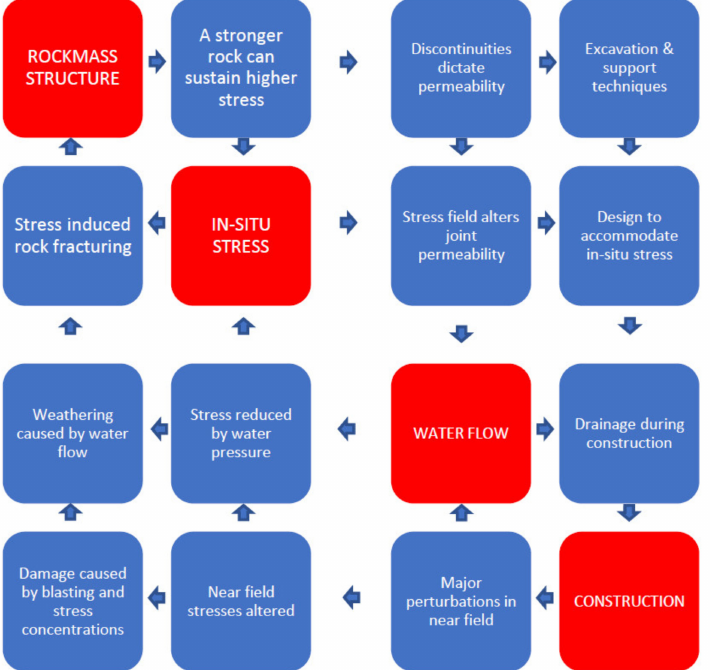
Figure 2. An example of a simple, four-variable, binary interaction matrix (BIM), modified from [10,11]. The four main variables are rock mass structure, in situ stress, water flow, and construc- tion, identified along the leading diagonal. The 12 binary interactions between the pairs of main variables are defined in the off-diagonal